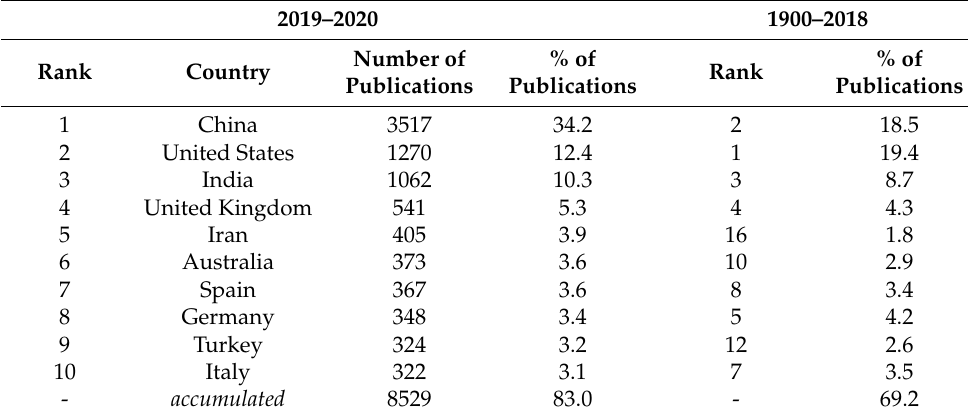
Table 2. Most productive countries in Solar Energy research comparison.